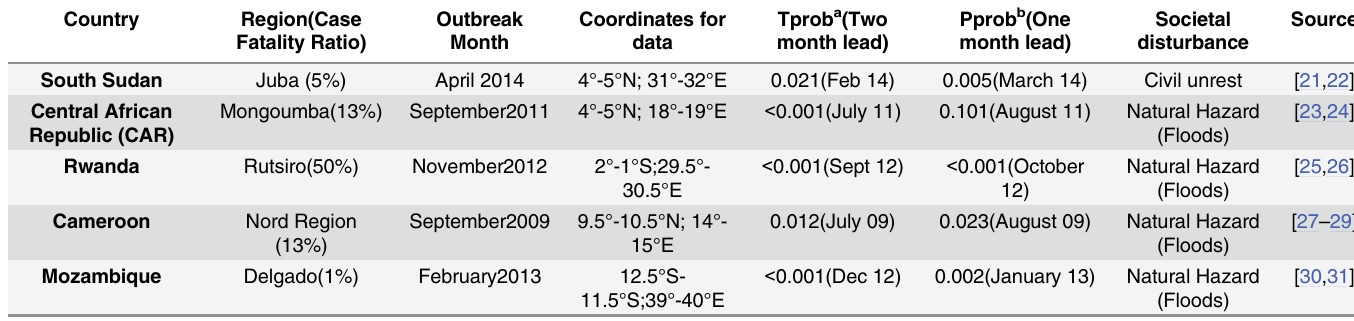
Table 1. Recent cholera epidemics in the African